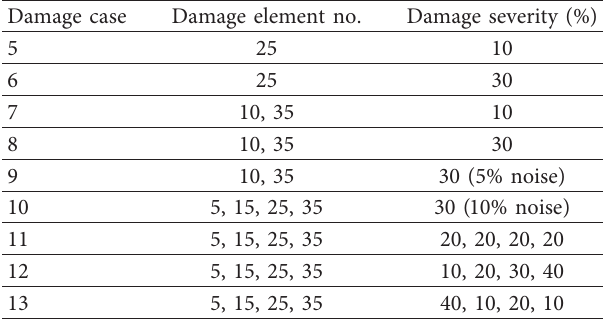
Table 3: Damage case studies in the hinged